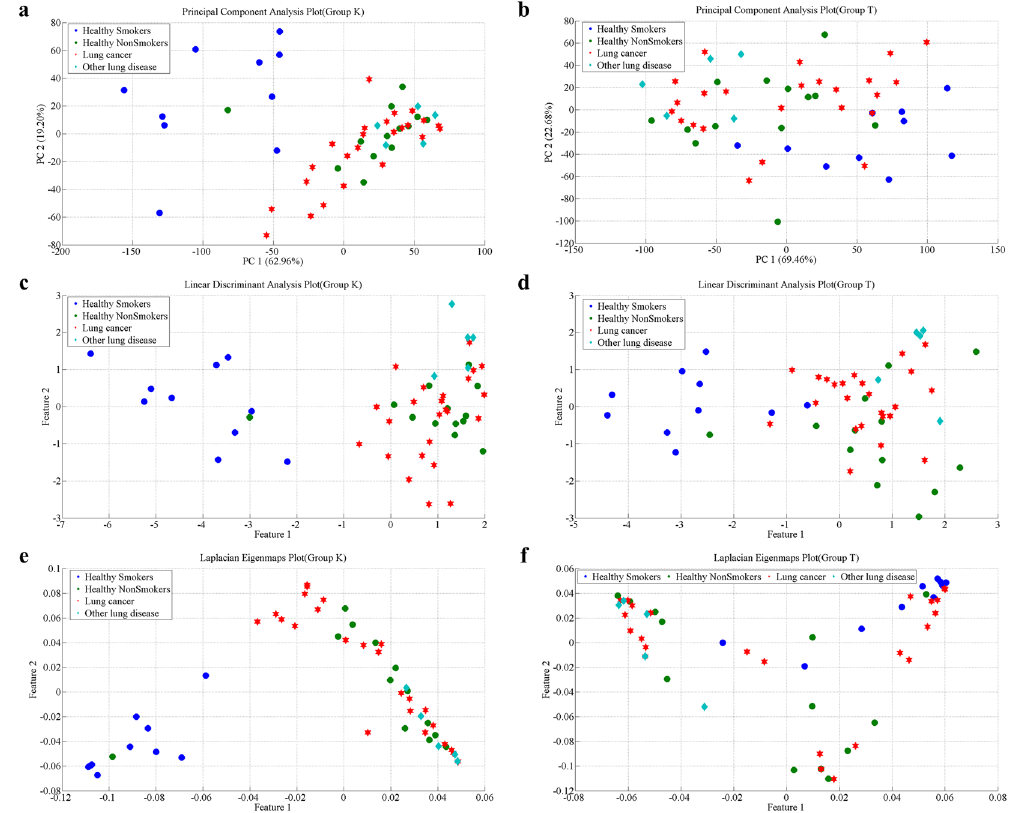
Figure 7. Mapping results of PCA, LDA and LE using data from sensor group T and group K. ( a , c , e) are 2D mapping plots of PCA, LDA and LE based on data obtained by sensor group K; ( b , d , f ) are 2D mapping plots of PCA, LDA, and LE based on data obtained by sensors of group